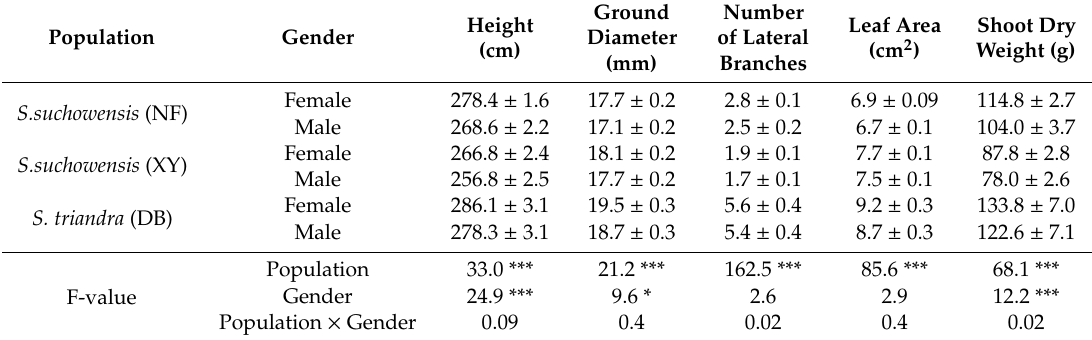
Table 4. Effects of gender on the growth of willow plants. 204 Table 4. E ff ects of gender on the growth of willow plants.